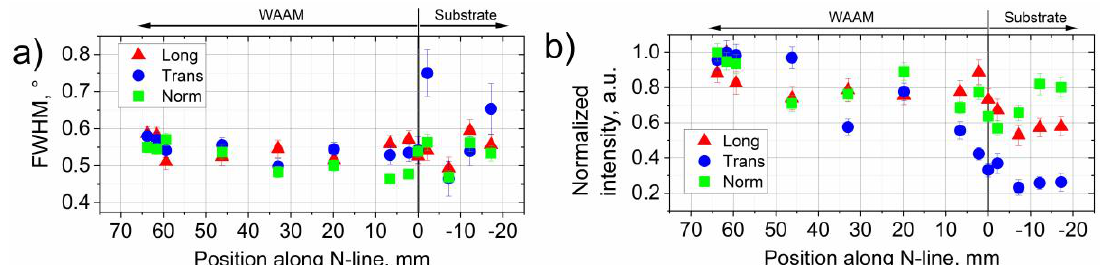
Figure 10. ( a ) FWHM and ( b ) normalized integrated intensity of the 112̅2 -Ti diffraction peak along the build direction.